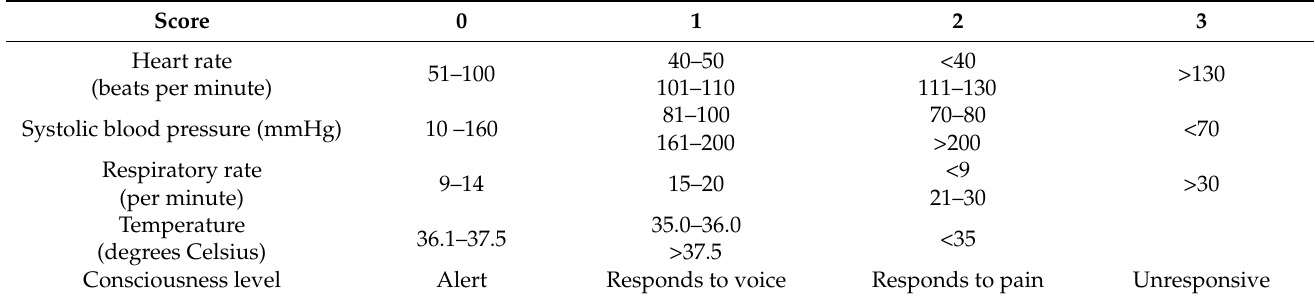
Table 2. Early warning score